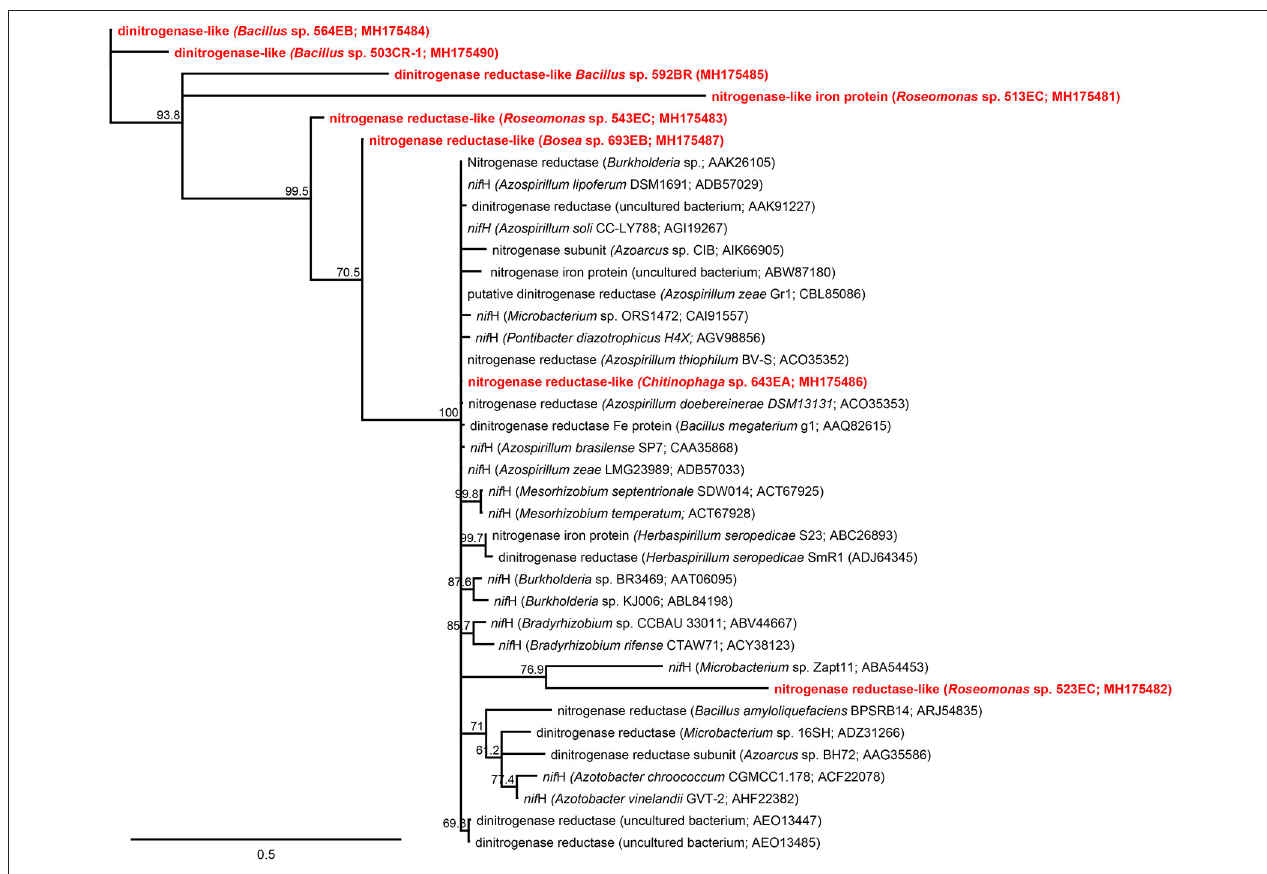
FIGURE 3 | Neighbor-joining tree showing the phylogenetic affiliation between predicted amino acid sequences from nif H gene obtained from rhizosphere and root endosphere isolates in this study (red) and representative nif H-coded enzyme amino acid sequences from known representative plant-soil bacteria deposited in NCBI GenBank database (black). Scale represents substitution sites (Bootstrap = 1,000). In parenthesis is shown the accession number of representative sequences in GenBank or the taxonomic affiliation based on 16S rRNA gene sequencing of